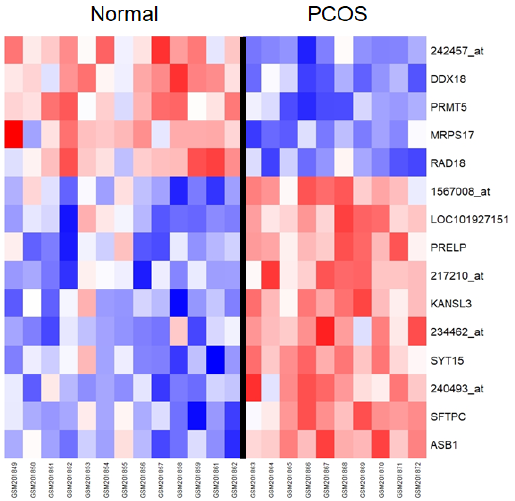
Figure 2. Heatmap of significant genes from the differentially expressed gene (DEG) analysis of the GSE8157 dataset. Probe names are used for annotation in cases where no genes were mapped to the probes. The genes are ordered according to the ascending order of t -statistics. Normal and PCOS groups are divided using a black line. PCOS — polycystic ovarian syndrome.